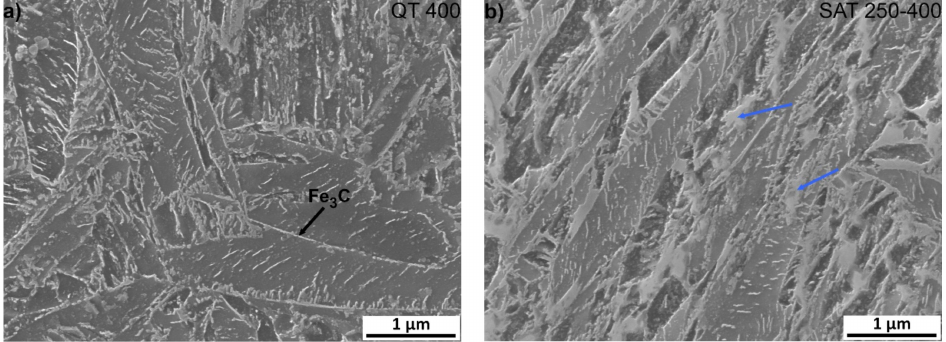
Figure 8. Microstructure analysis of samples after quenching and tempering at 400 ◦ C, ( a ) QT and ( b ) SAT processing. Blue arrows indicate bright islands with the lower